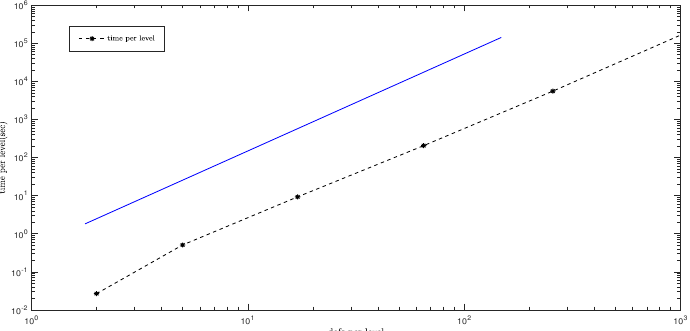
Figure 2. Total CPU time for the MLMC-HDG approximation of E L ( u ) and E L ( q ) .